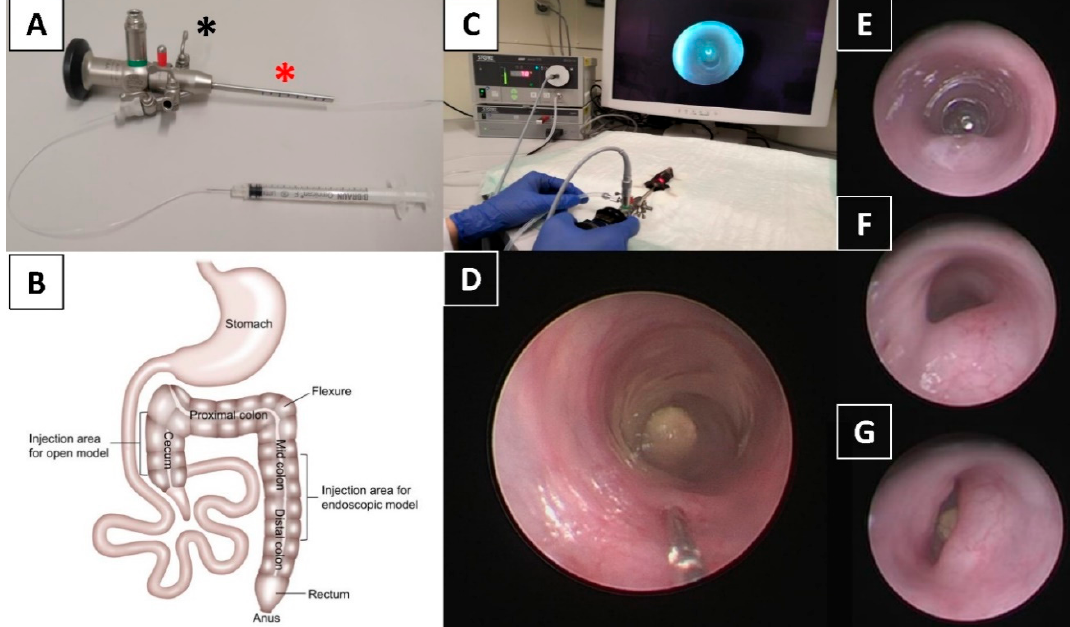
Figure 6. Endoscopy-guided minimally invasive orthotopic mouse model of colorectal cancer using the Mainz Coloview mini-endoscopic system. ( A ) Zero-degree optic (1.9 mm) with a 9 Fr. sheath including a 3 Fr. working channel and a gradation for insertion control (red asterisk). The valve of the Luer lock adapter (black asterisk) is adjusted to create a slow constant air flow. ( B ) Murine anatomy of the colorectum showing the injection sites of open models (injection via laparotomy) [32] and the endoscopic model of the current study. Injection is performed into the lower mid and distal colon in this study. ( C ) Examination and injection with a mouse in dorsal position on a covered heated pad. ( D ) The colonic mucosa is gently penetrated in an approximately 20° to 30° angle using an attached